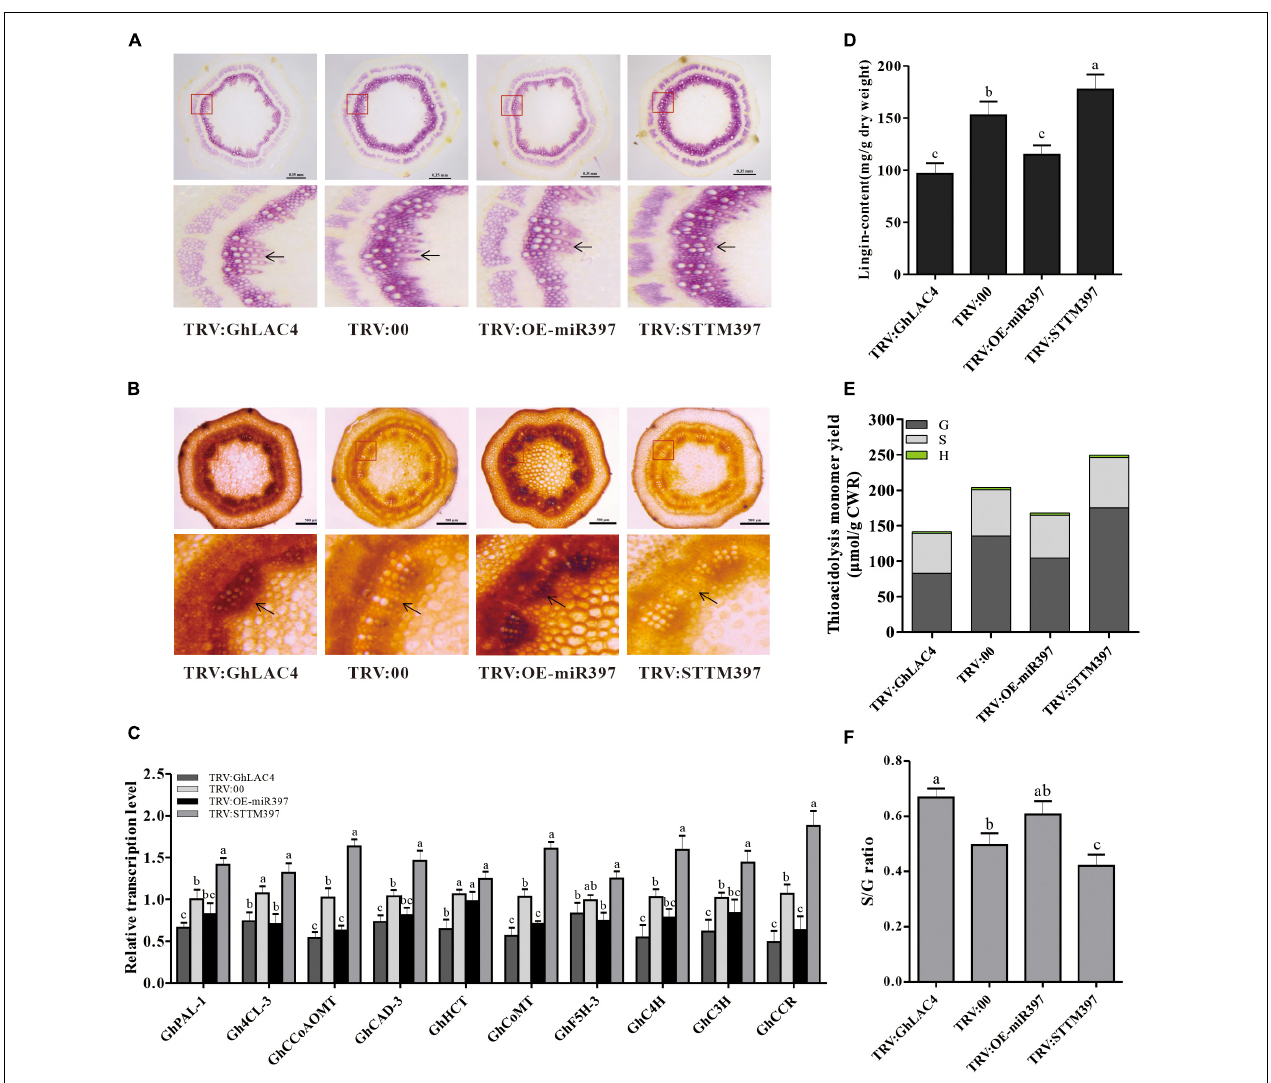
FIGURE 6 | Analysis of expression levels of lignin biosynthesis-related genes and lignin content and composition. (A,B) Stem cross slices stained with phloroglucinol-HCl (A) and Maüle staining method (B) in TRV:STTM397, TRV:OE-miR397, TRV:GhLAC4, and the control plants. The red boxes in up panels are enlarged as shown in down panels; the black arrow points to lignin fibres. Scale bars in (A) is 0.35 mm, (B) scale bars is 500 µ m. (C) The relative expression levels of lignin biosynthesis-related genes in TRV:STTM397, TRV:OE-miR397, TRV:GhLAC4, and the control plants. (D) Analysis of Klason lignin content in